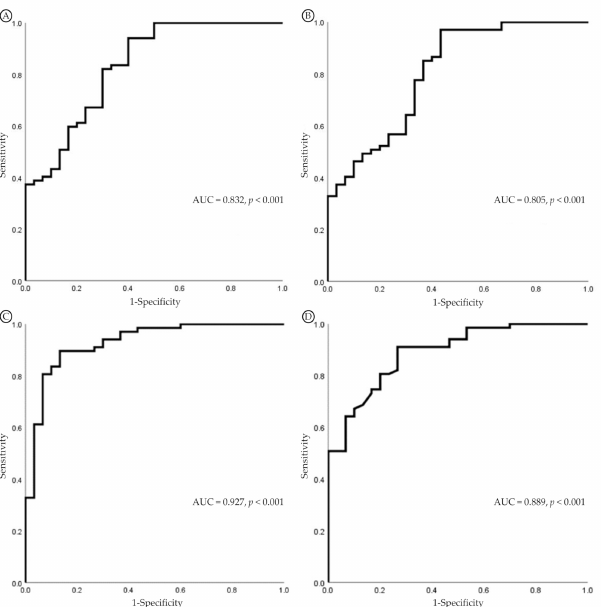
Figure 3. Receiver operating characteristic (ROC) curves for the diagnosis of CTS. ( A ) UV. ( B ) APDW. ( C ) FR. ( D ) TAPDM. Abbreviations: CTS, carpal tunnel syndrome; UV, ulnar variance; APDW, AP diameter of the wrist; FR, flattening ratio; TAPDM, thickest AP diameter of the median nerve; AUC, area under the